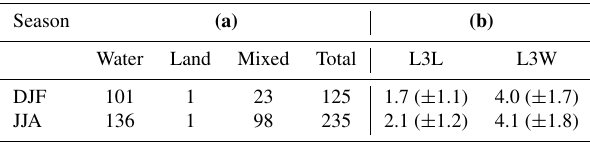
Table 1. (a) Surface classification of L3 data for the 1 ◦ × 1 ◦ grid box containing Halifax (L3O) for the period 25 August 2001 to 5 March 2017. Note that no retrievals are available for this L3 grid box on 91% of days in DJF and 83% of days in JJA. (b) Mean number of individual L2 retrievals with land and water surface index that con- tribute to the L3L and L3W time series, respectively (the standard deviation is in